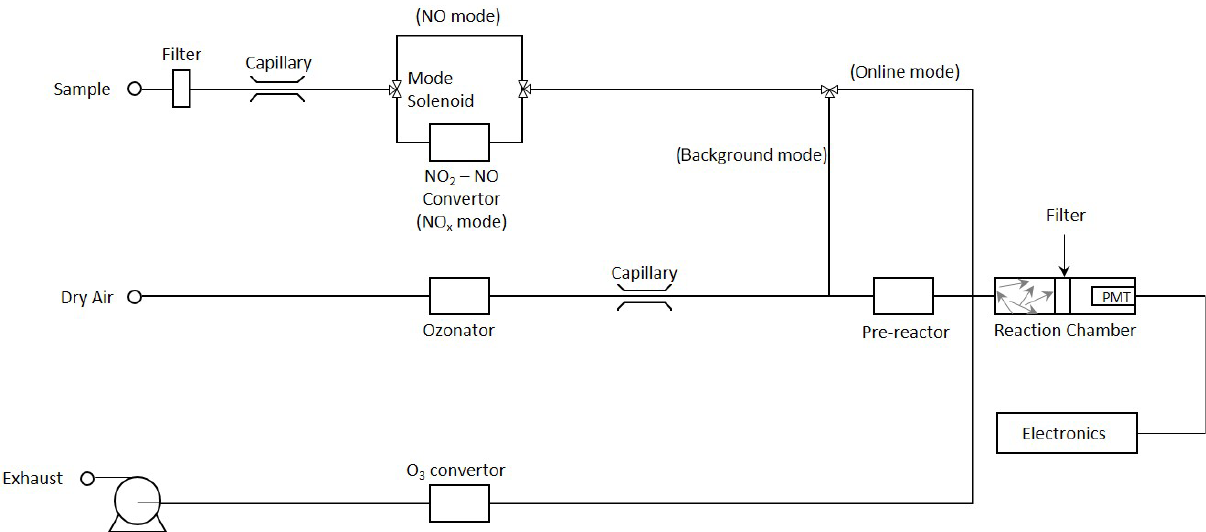
Figure 1. A typical flow schematic of a chemiluminescent NO monitor.